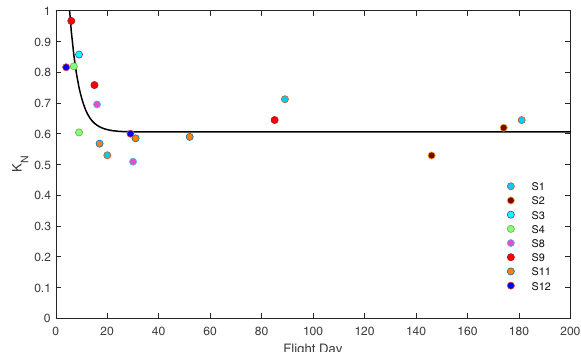
Fig. 6 In- fl ight adaptation. K N , normalized K- values of all in- fl ight experiments plotted as a function of the experimental fl ight-day. Inset: color-coding of different astronauts. Parameters of exponen- tial fi tting (Eq. 5): τ = 3.666, a = 1.317, b = 0.896, c =